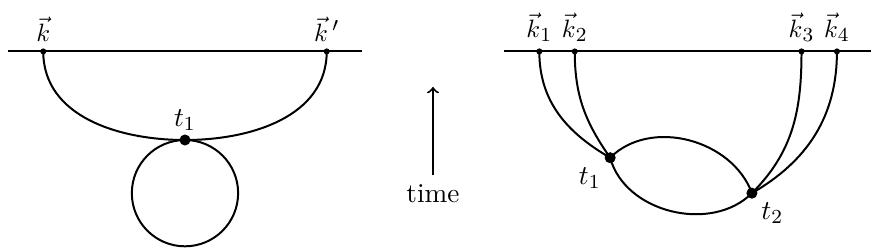
Figure 2 . Diagrams for the one-loop matching, as computed in the UV theory. The horizontal line indicates a surface on constant conformal time τ Left: one-loop power spectrum. Right: one-loop